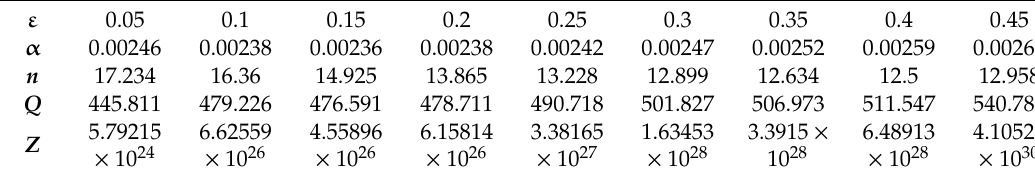
Figure 6. Predicted stress by Arrhenius equation at: ( a ) 0.002/s; ( b ) 0.02/s; ( c ) 2/s; ( d ) 20/s Table 3. Parameters for Arrhenius